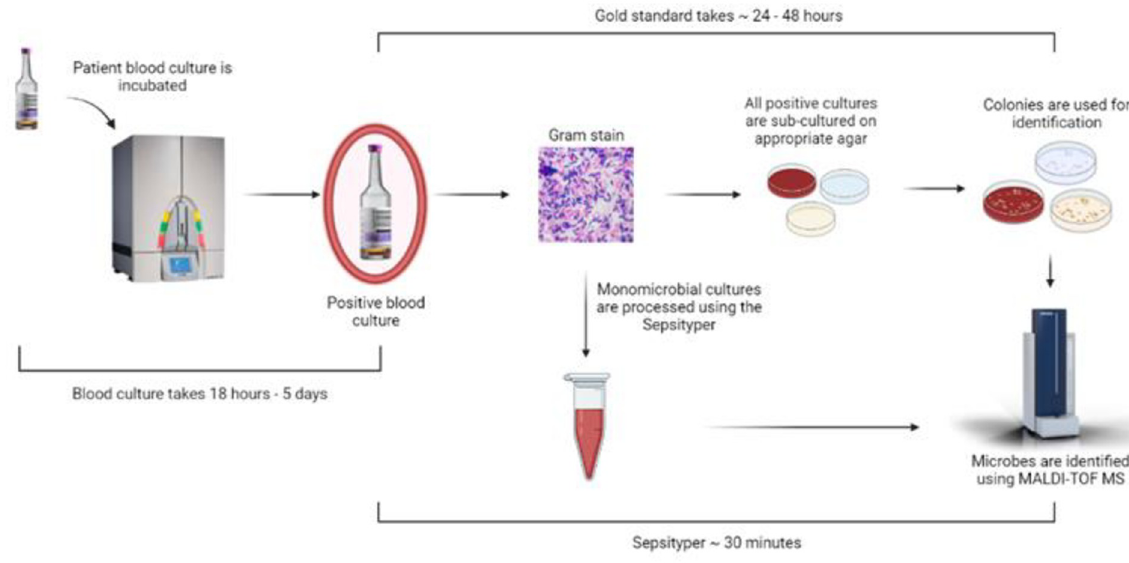
Fig 1. Patient enrolment. Of the 68 patient samples, 25 had Sepsityper analysis performed as part of routine